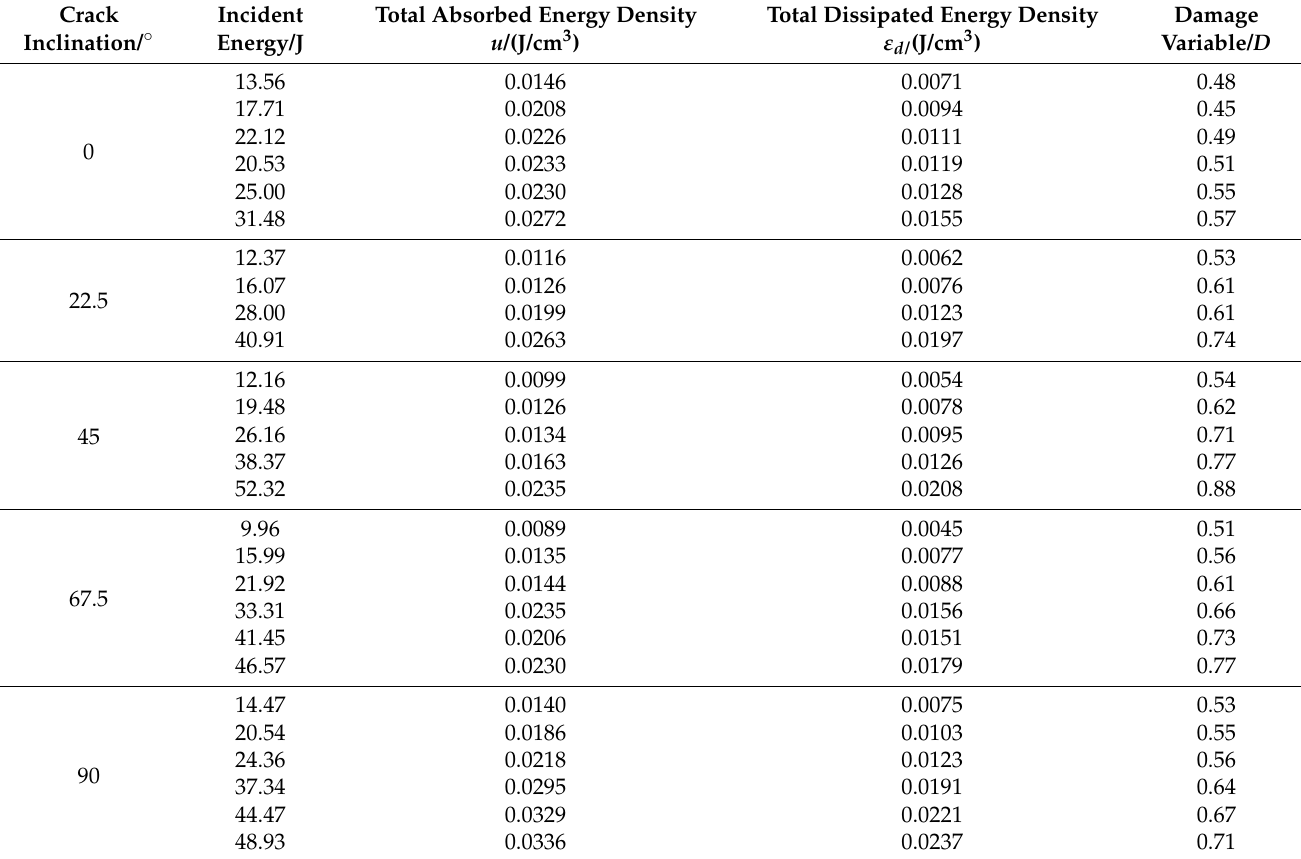
Table 2. Calculation results of the damage